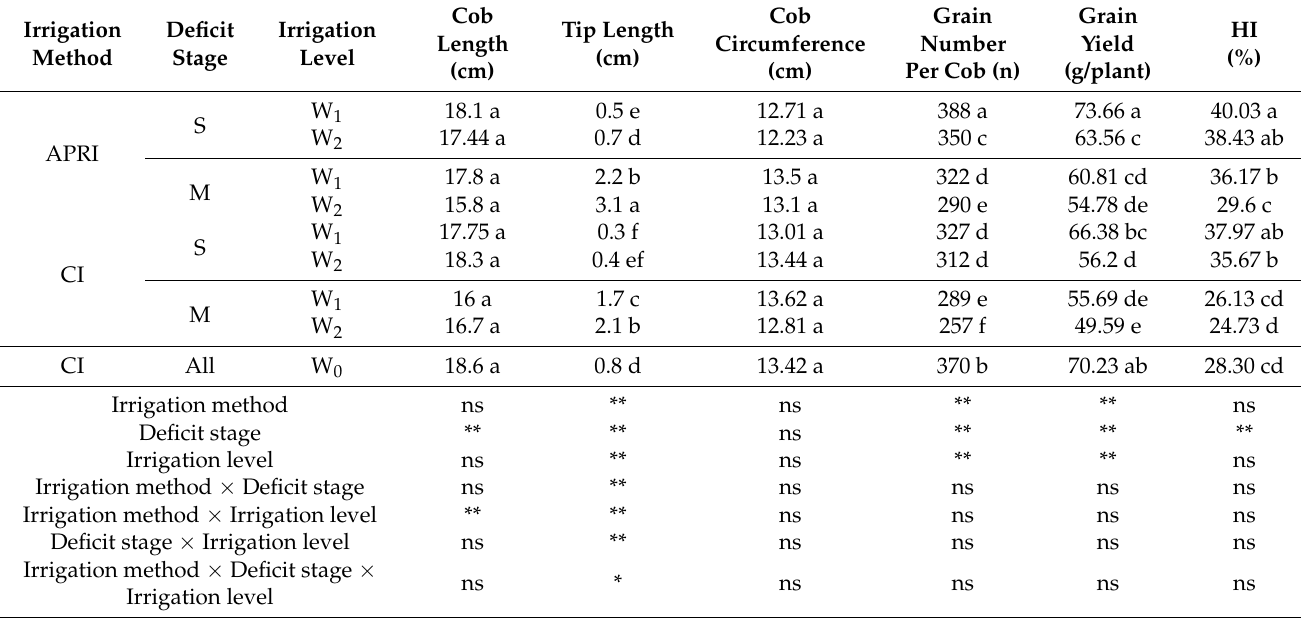
Table 5. Effects of different irrigation levels and deficit stages on the grain yield and its traits of maize under alternate partial root-zone